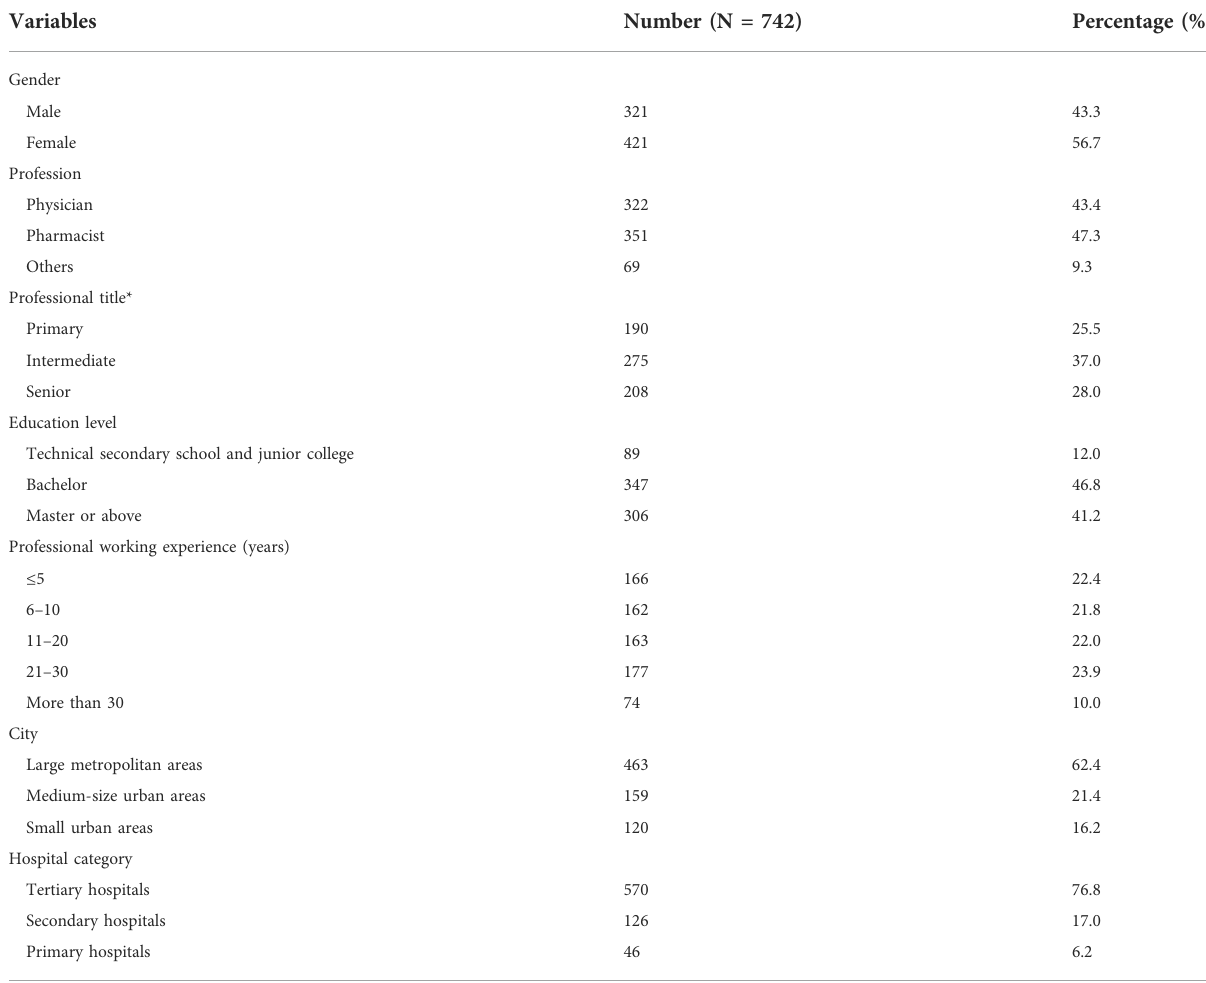
TABLE 1 Demographic characteristics of the studied